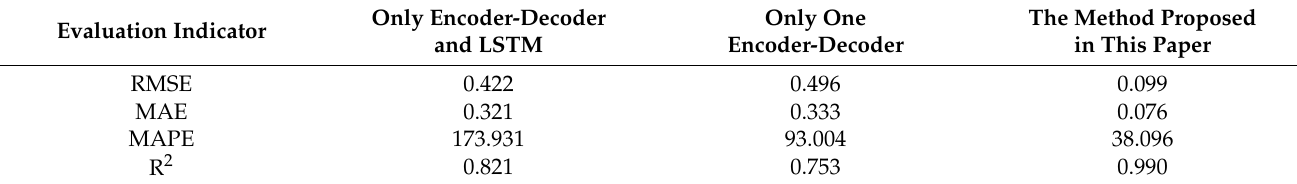
Table 6. Scores of the two